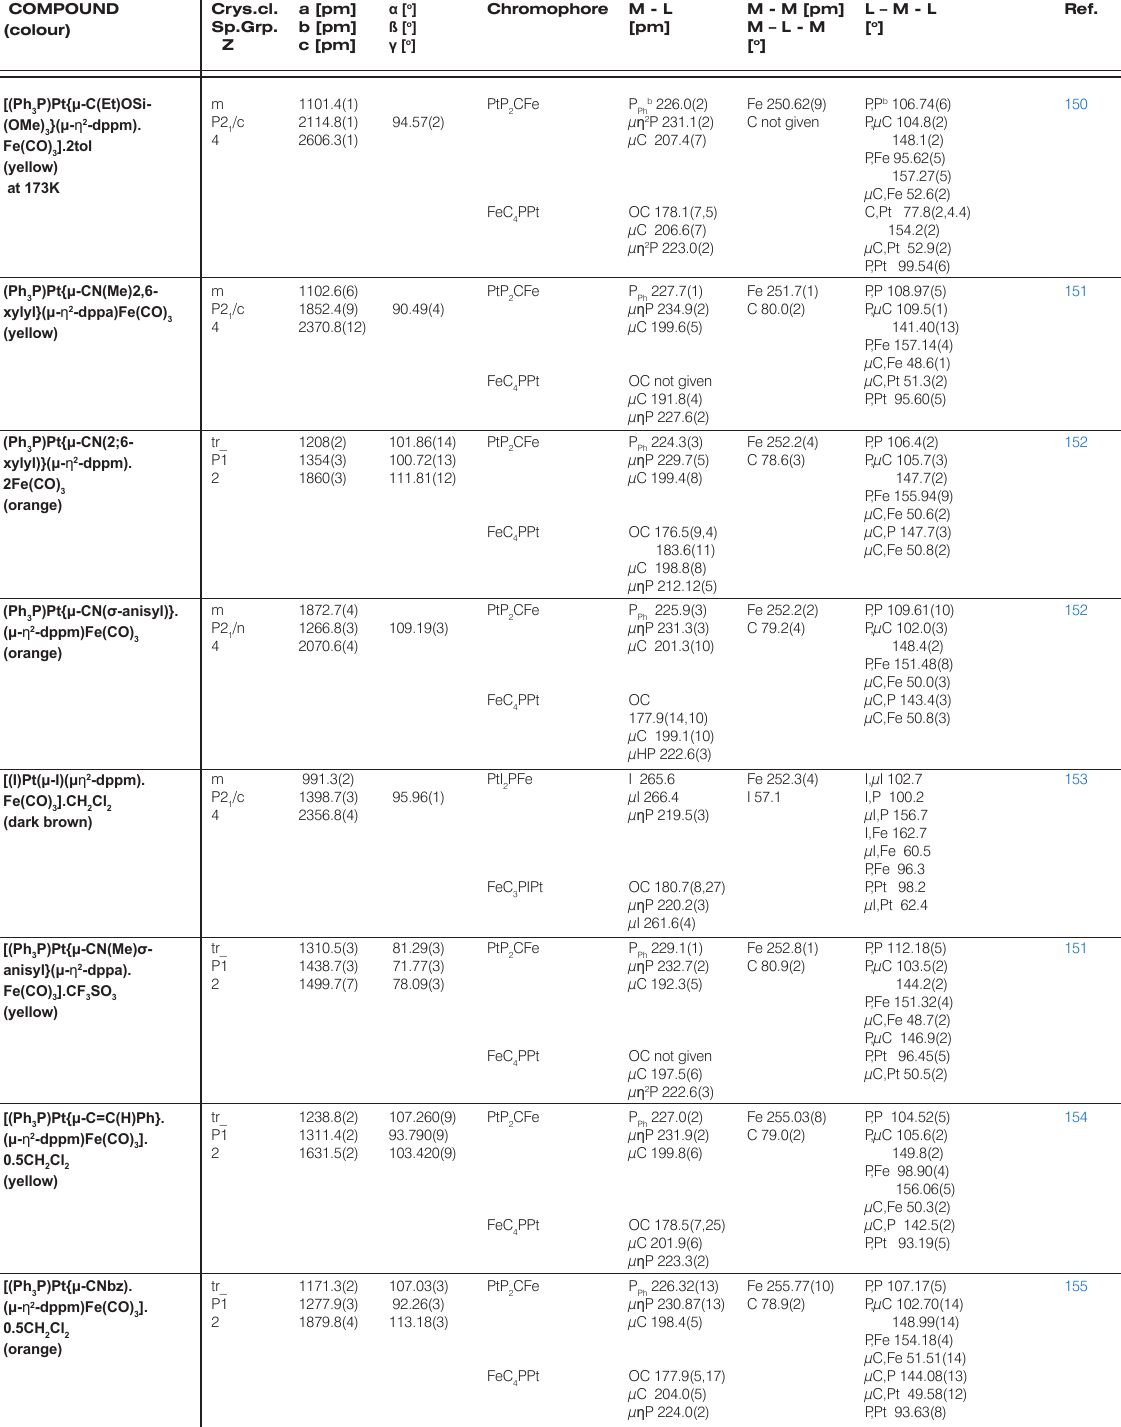
Table 5. Heterobinuclear Platinum Compounds with Pt-M Bond (M = Fe or Ru) a